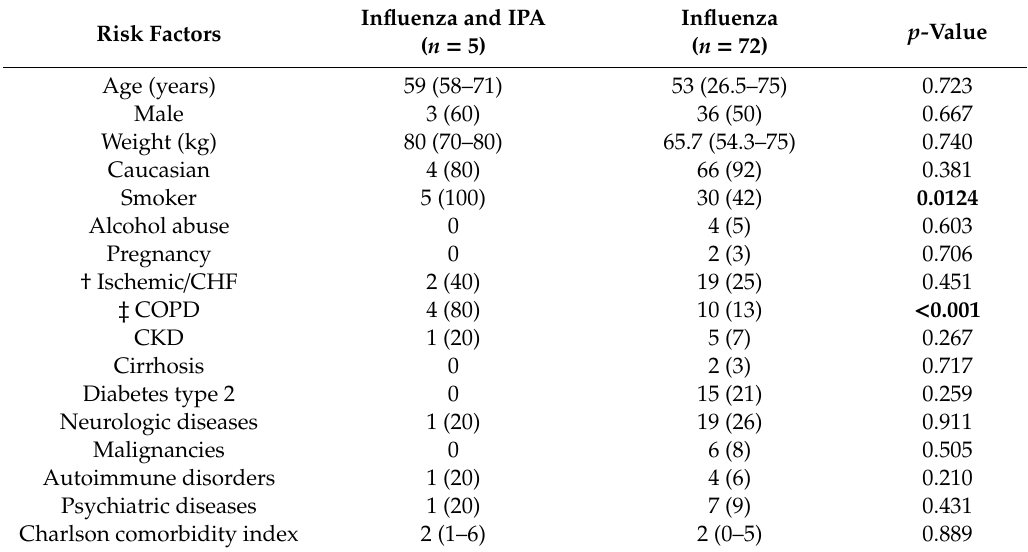
Table 2. Preexisting risk factors associated with IPA in influenza